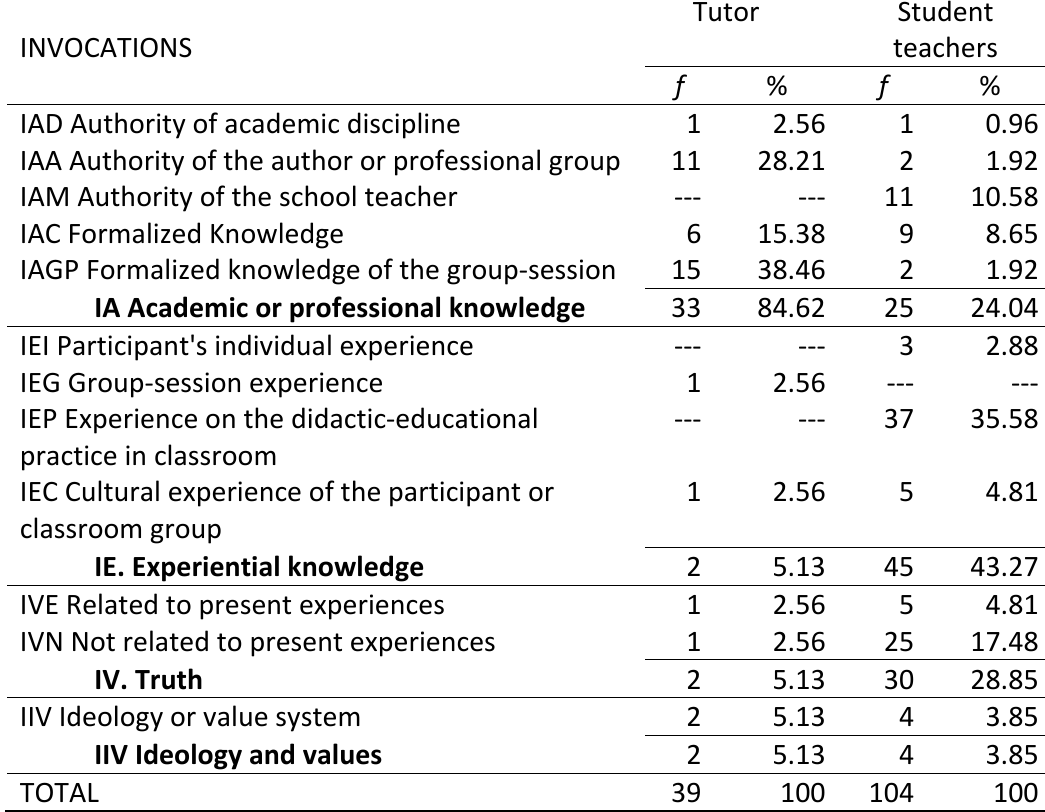
Table 4. Profile of invocations used by the Practicum tutor and the student teachers in case F,